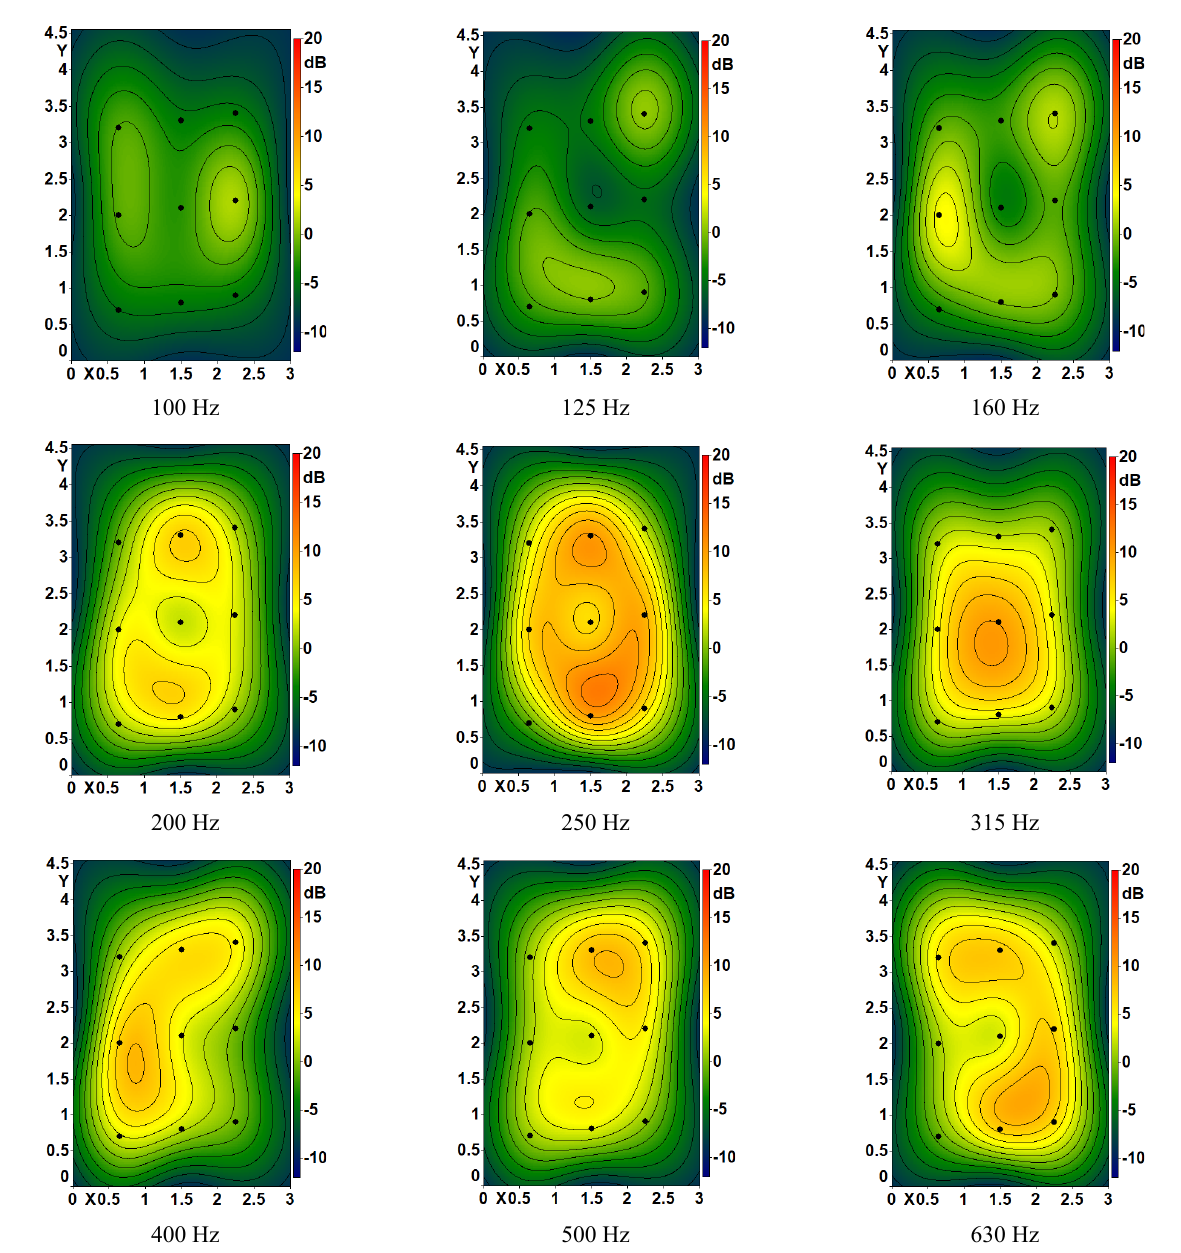
Figure A3. Rubber ball radiation index maps. Average between the three source positions.